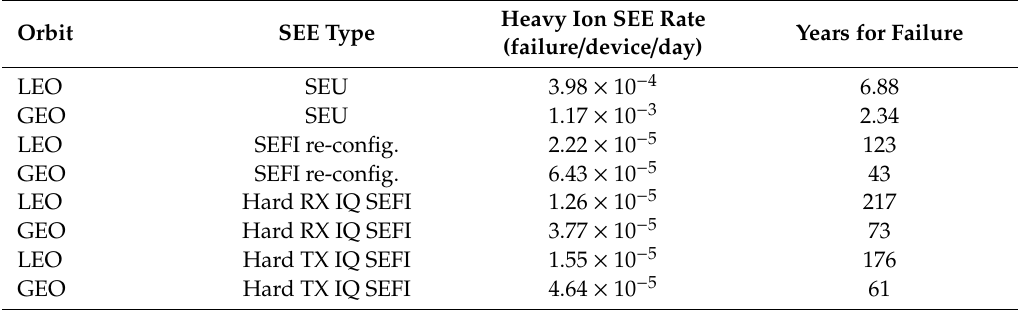
Table 4. Error rates for two references missions and the observed SEEs (launch date: 1st December 2019) under nominal conditions.